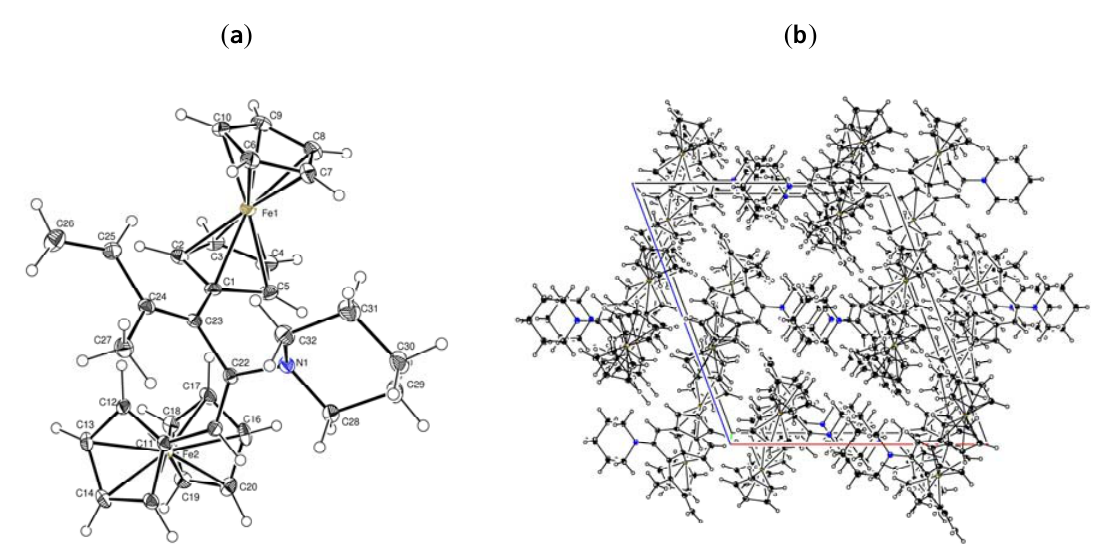
Figure 3. ( a ) X-ray crystal structure of 10b ; ( b ) Crystal packing of 10b